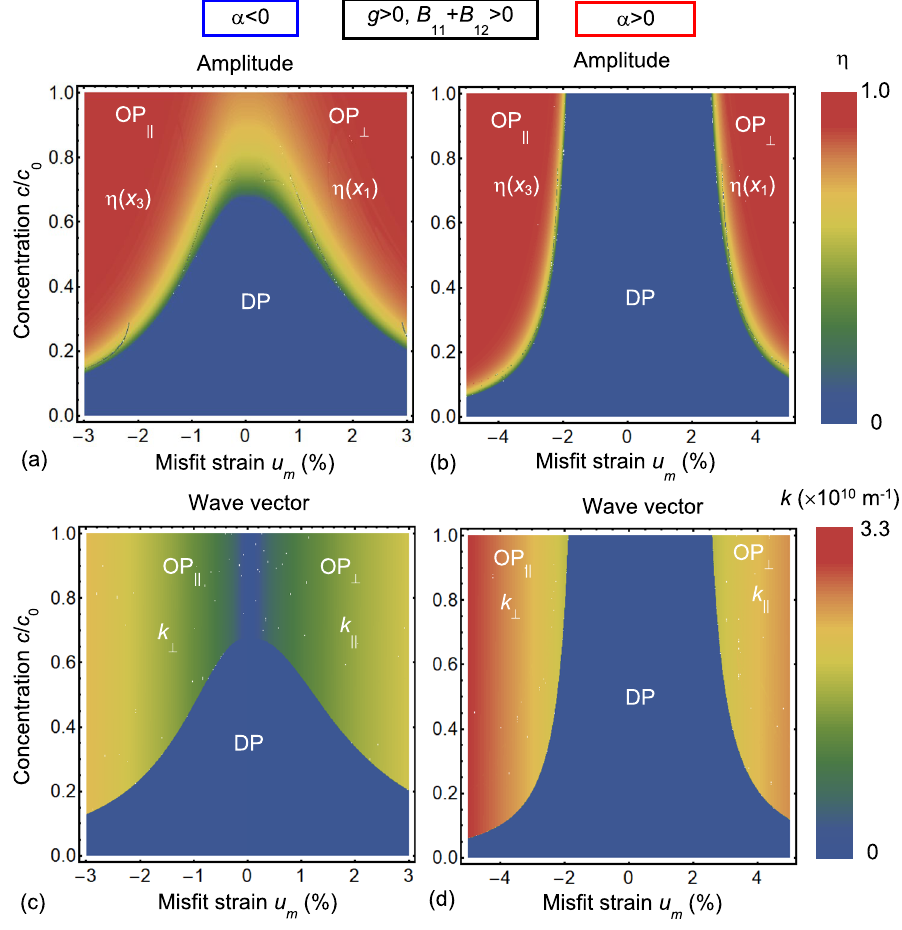
Figure 5. Order parameter amplitudes η( x 1 ) and η( x 3 ) ( a , b ) and wave vectors ( c , d ) in dependence on normalized defect concentration c / c 0 and misfit strain u m calculated for negative α ( a , c ) and positive α (b , d ); g > 0 , and B 11 + B 12 > 0 . Numerical values of parameters are the same as in Fig.